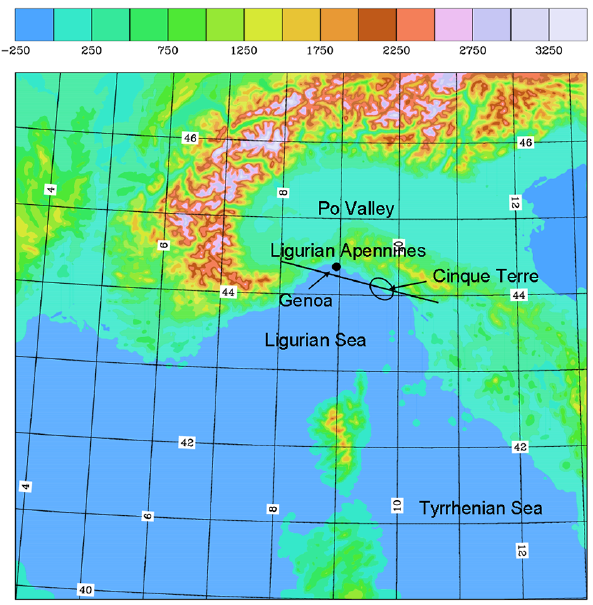
Figure 1. Integration domain of the MOLOCH experiments. The black line marks the cross-section location of Fig. 11. Geographical names are indicated. Colours represent the orography according to the associated scale. Parallels and meridians are drawn every 1 ◦